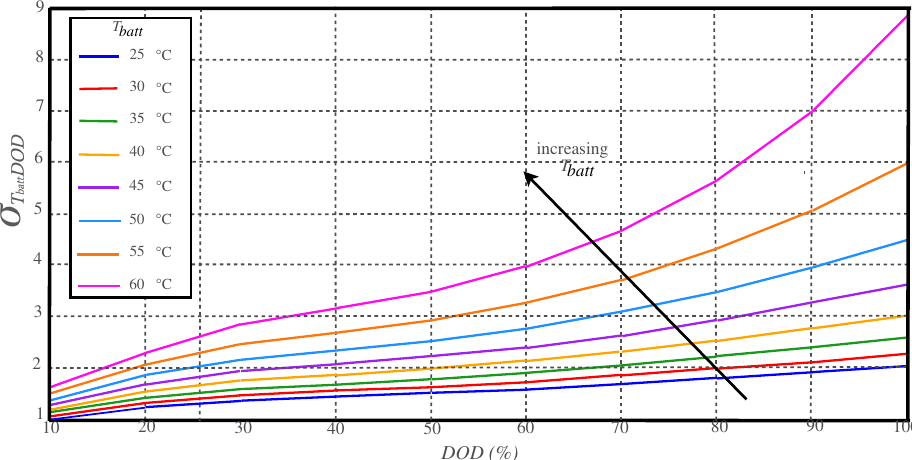
Figure 4. Severity factor map depending on DOD and battery